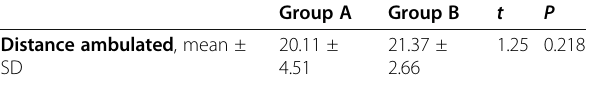
Table 6 Comparison between the two groups regarding distance ambulated during the 48 h from operation Group A Distance ambulated , mean ± SD